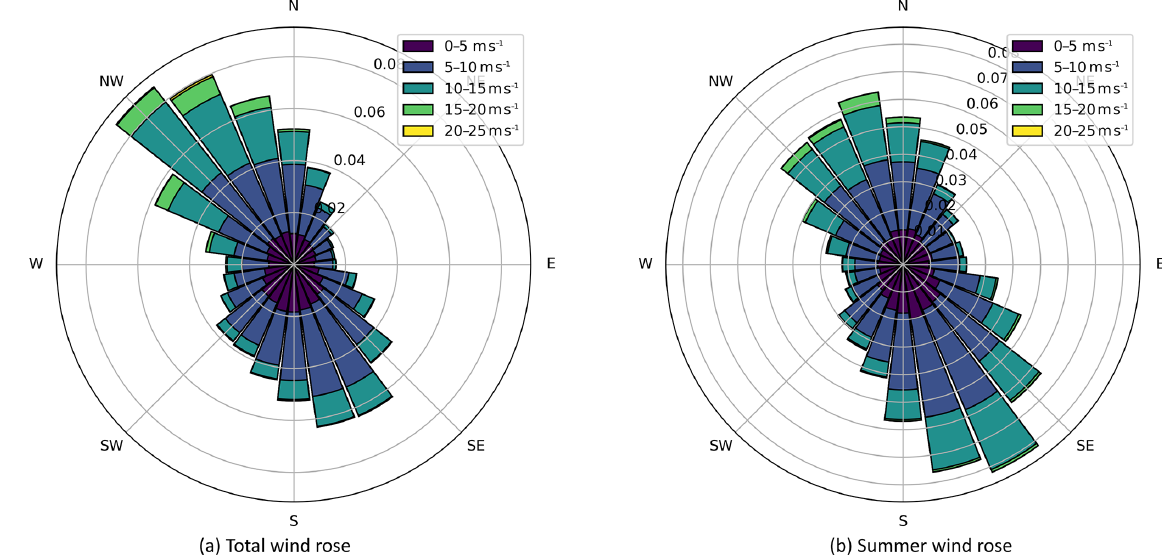
Figure 3. Total wind rose for the site and for the particular months encompassing the test based on data collected from https://www.nrel. gov/grid/wind-toolkit.html (last access: 1 May 2019).